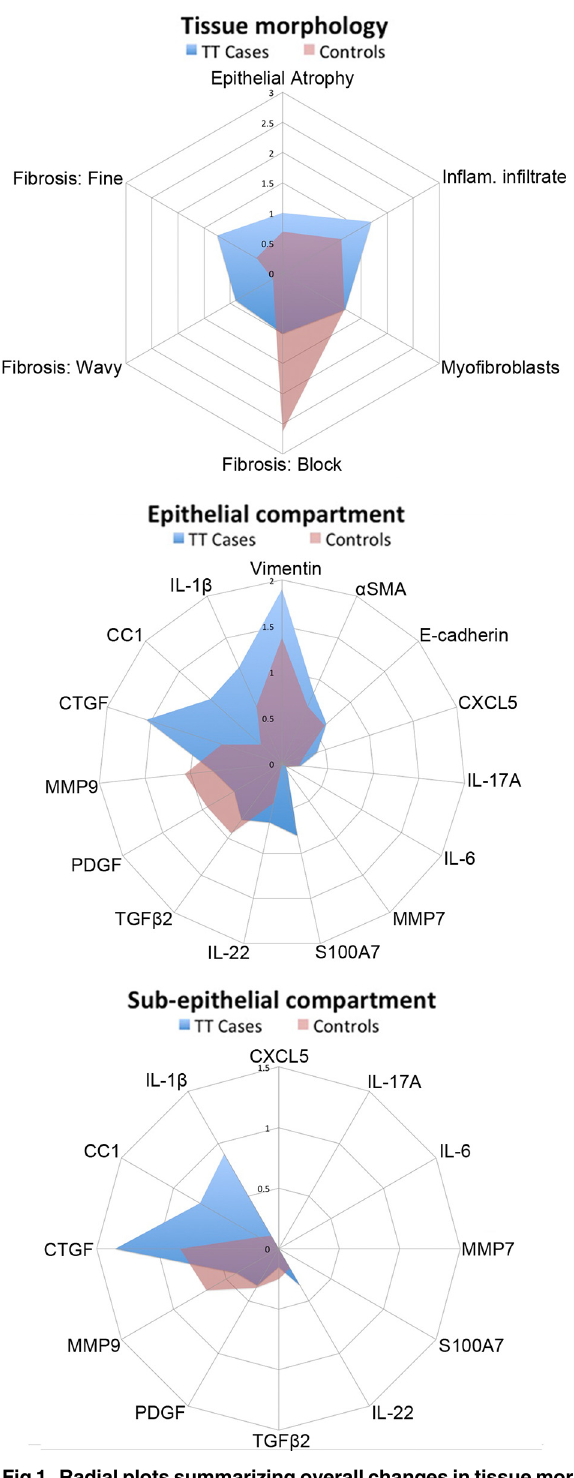
Fig 1. Radial plots summarizing overall changes in tissue morphology and expression of molecular markers. Molecular marker expression was quantified by IHC in the epithelial and subepithelial compartments. The average score per person for TT cases (blue) and controls (red) was plotted for each target or H&E feature.